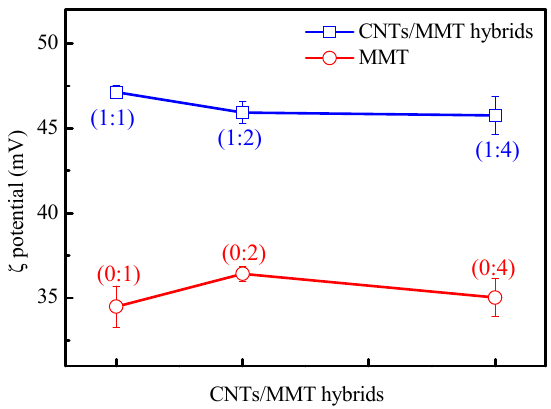
Figure 3. ζ potentials of MMT and CNTs/MMT suspensions with various ratios after standing for 72 h.